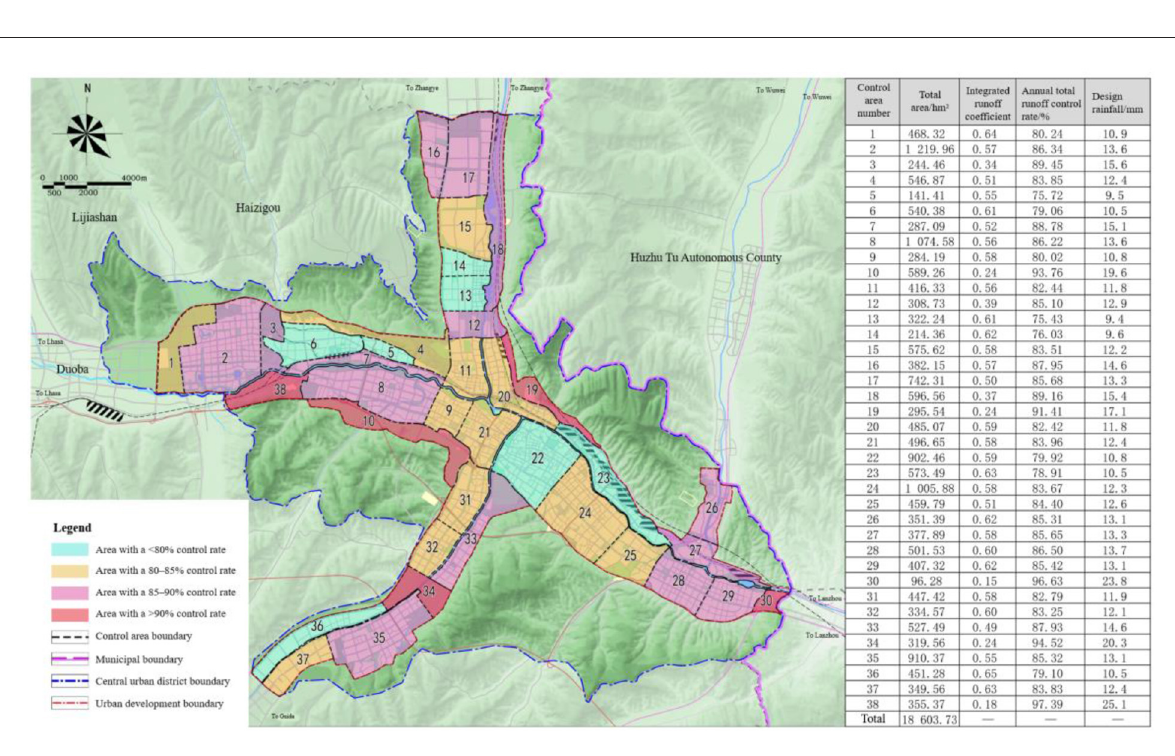
FIGURE11 Decomposition of the annual total runoff control rate indicator for the sponge city construction in